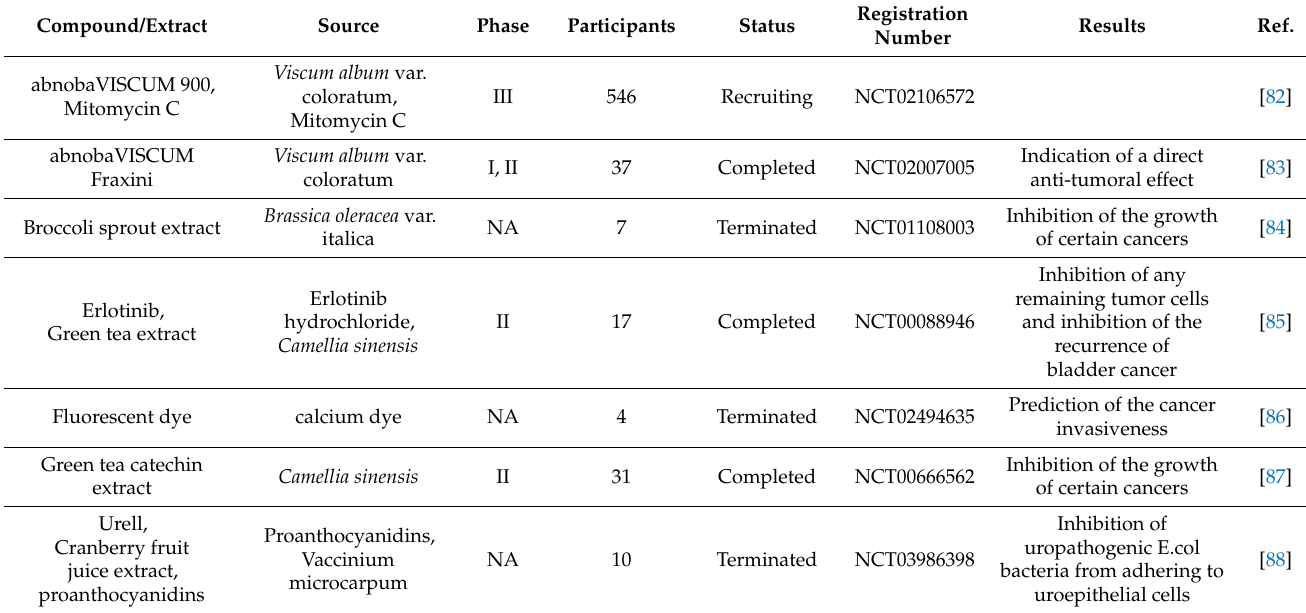
Table 7. Clinical